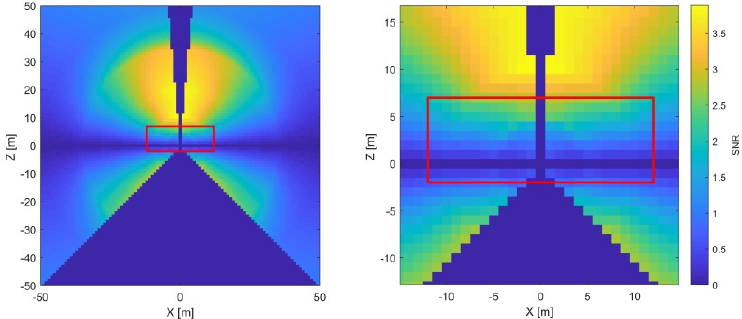
Figure 9. SNR for x 5 n in a vertical plane—full field of view ( left ) and the close-up ( right ). Figure 9. SNR for 𝑥 (cid:2873)(cid:3041) in a vertical plane—full field of view (left) and the close-up (right).